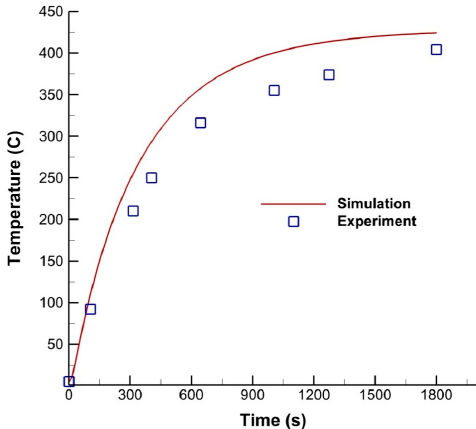
Figure 11. Temperature at the center point of the back side of the steel plate as a function of time during the steel preheating process.